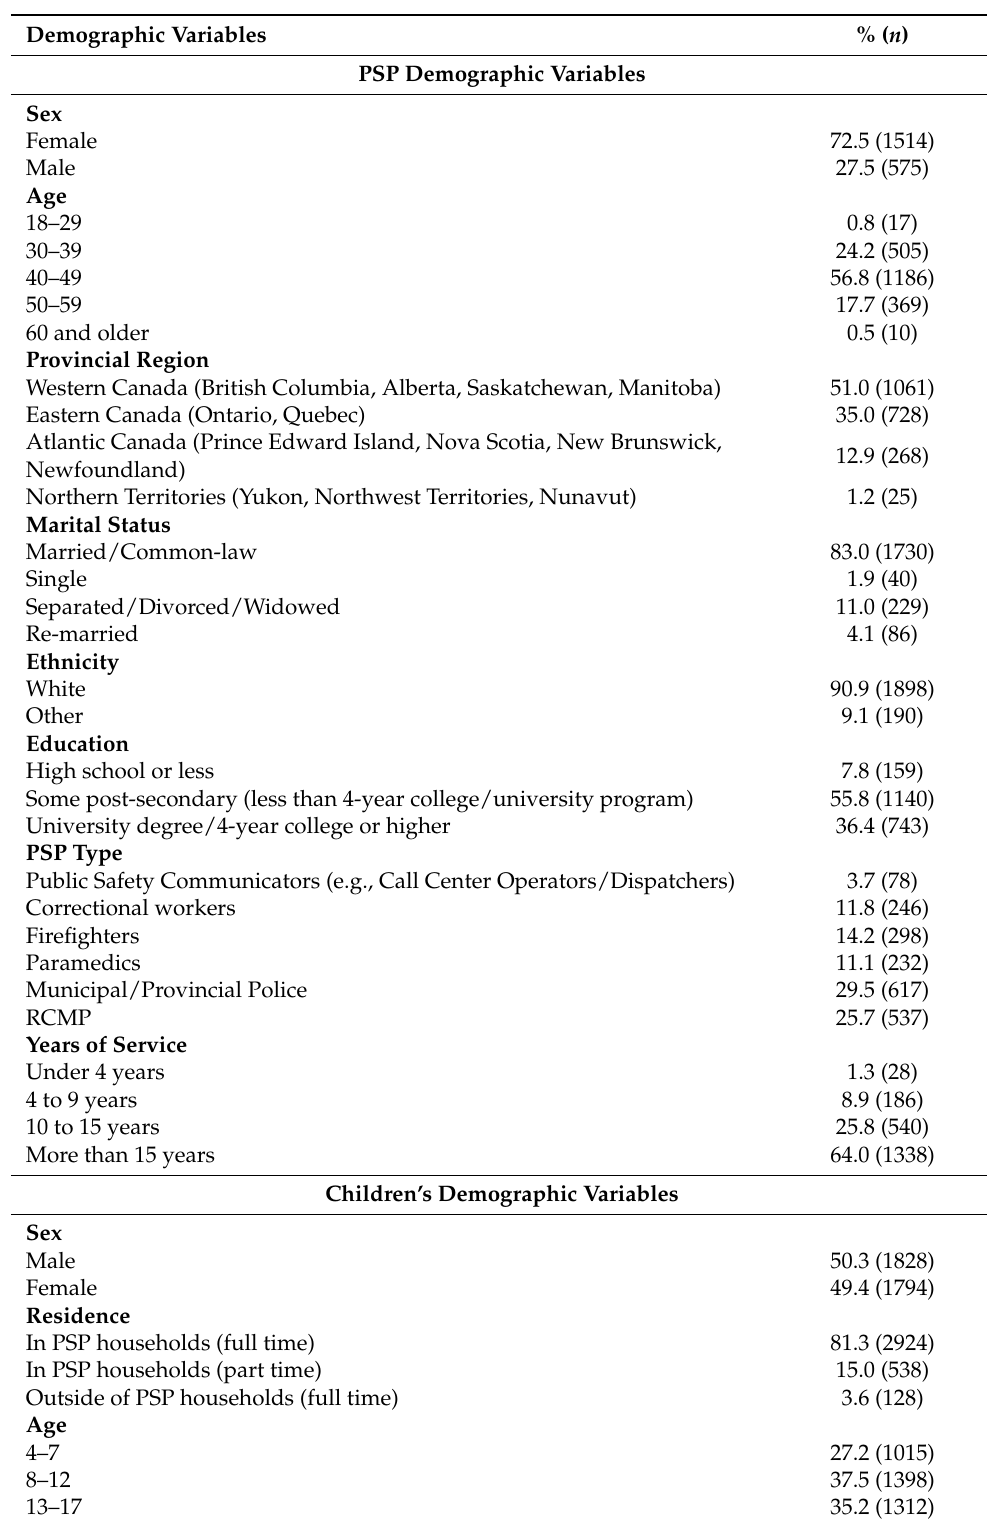
Table 1. Sociodemographic distribution among public safety personnel and their